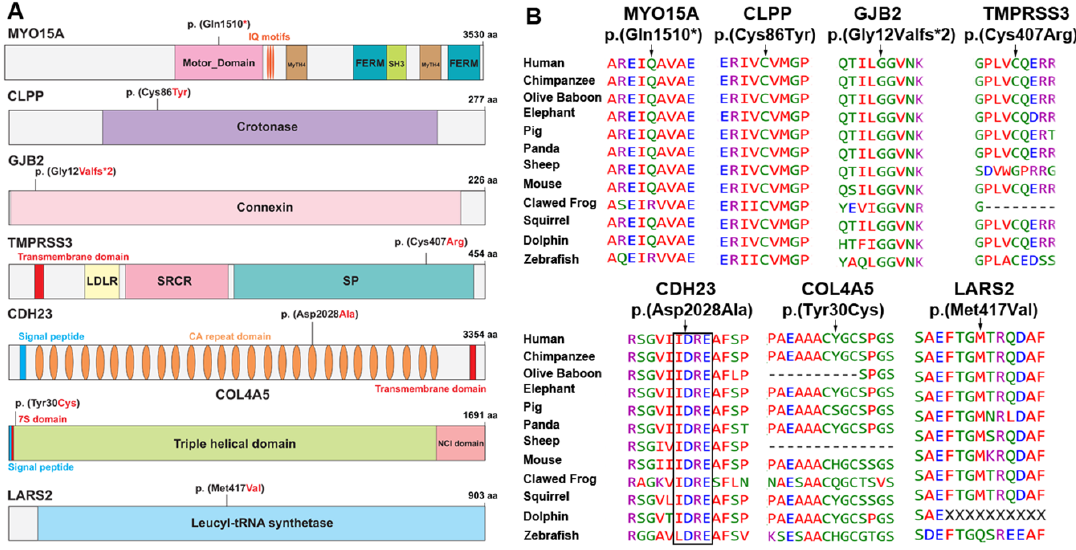
Figure 2. Protein structures and amino acid sequence alignments of orthologs. ( A ) Schematic representation of MYO15A, CLPP, GJB2, CDH23, COL4A5, and LARS2 proteins along with HL-associated variants identified in Pakistani families. ( B ) Clustal-W multiple amino acid sequence alignments of orthologous proteins showed evolutionarily conserved mutated residues across different species, except for the p.(Tyr30Cys) variant of COL4A5. However, none of the evaluated species had cysteine at position 30 in COL4A5 orthologs.